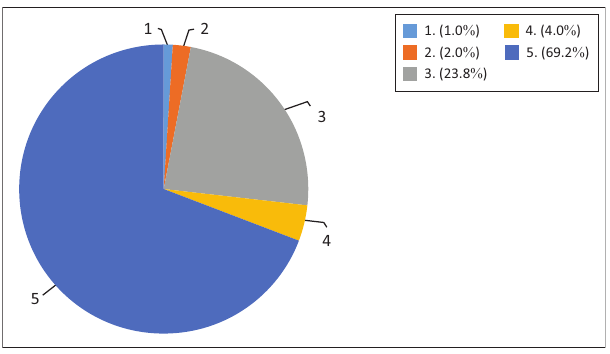
FIGURE 5: Participant responses about where they had their last eye